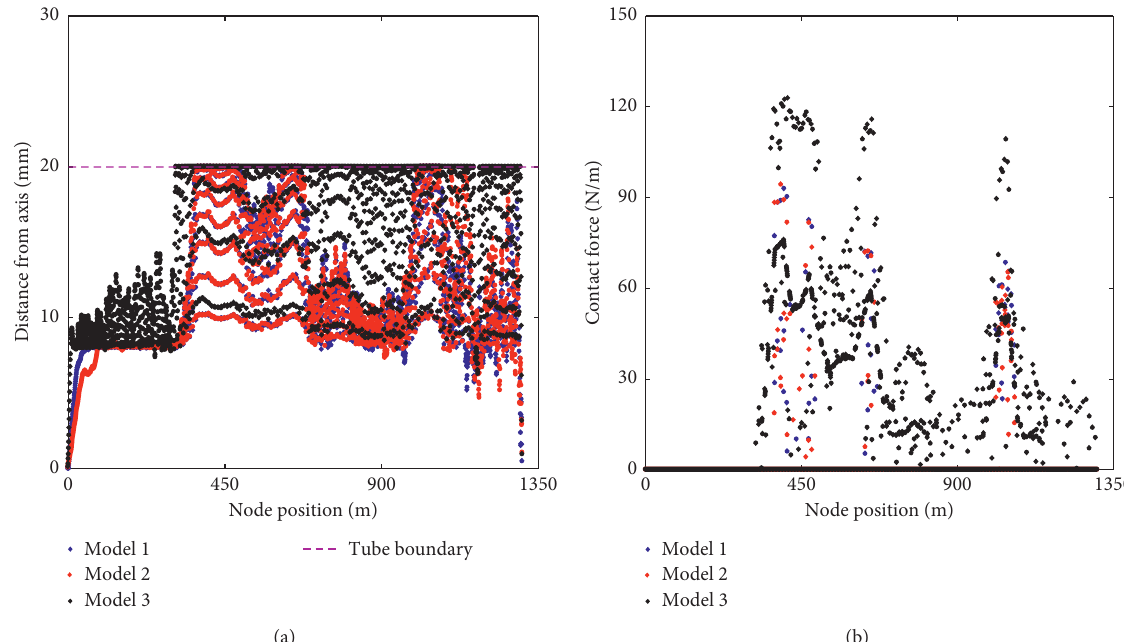
Figure 7: The rod node simulation results at 3s. (a) Distance between node position and borehole axis. (b) Contact force between rod and